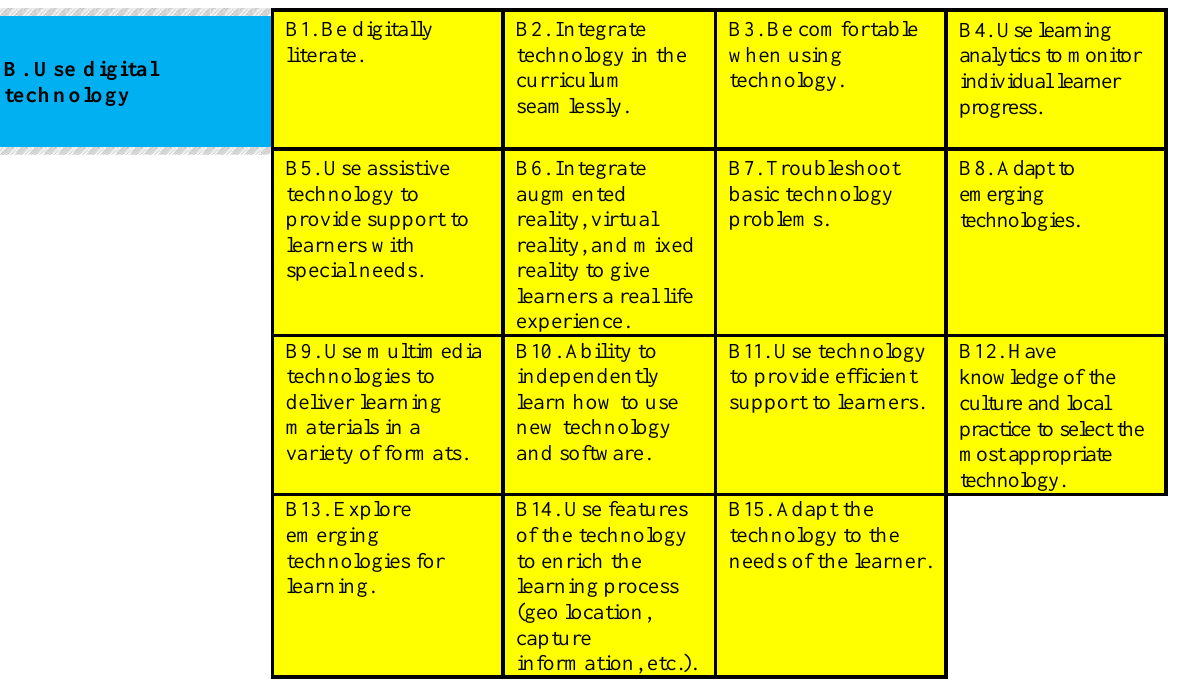
Figure 4. Use of digital technology competencies for the digital teacher.